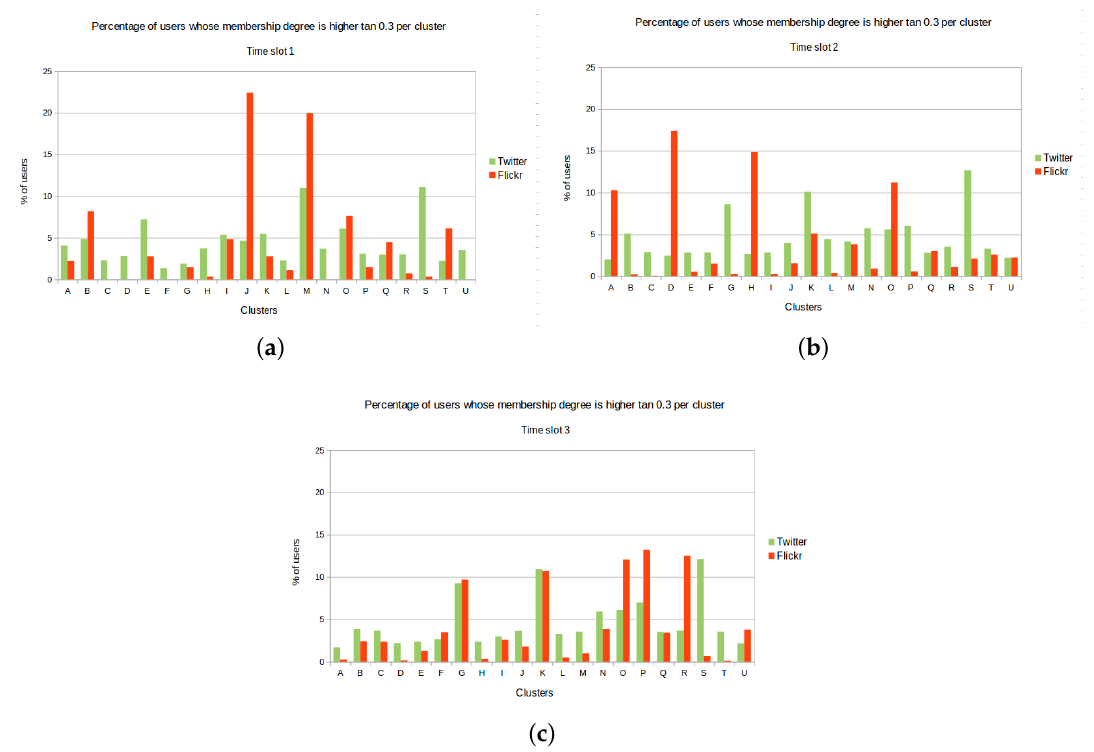
Figure 9. Distribution of OSN users per cluster in MD dataset. ( a ) night slot (1); ( b ) morning slot (2); ( c ) afternoon slot